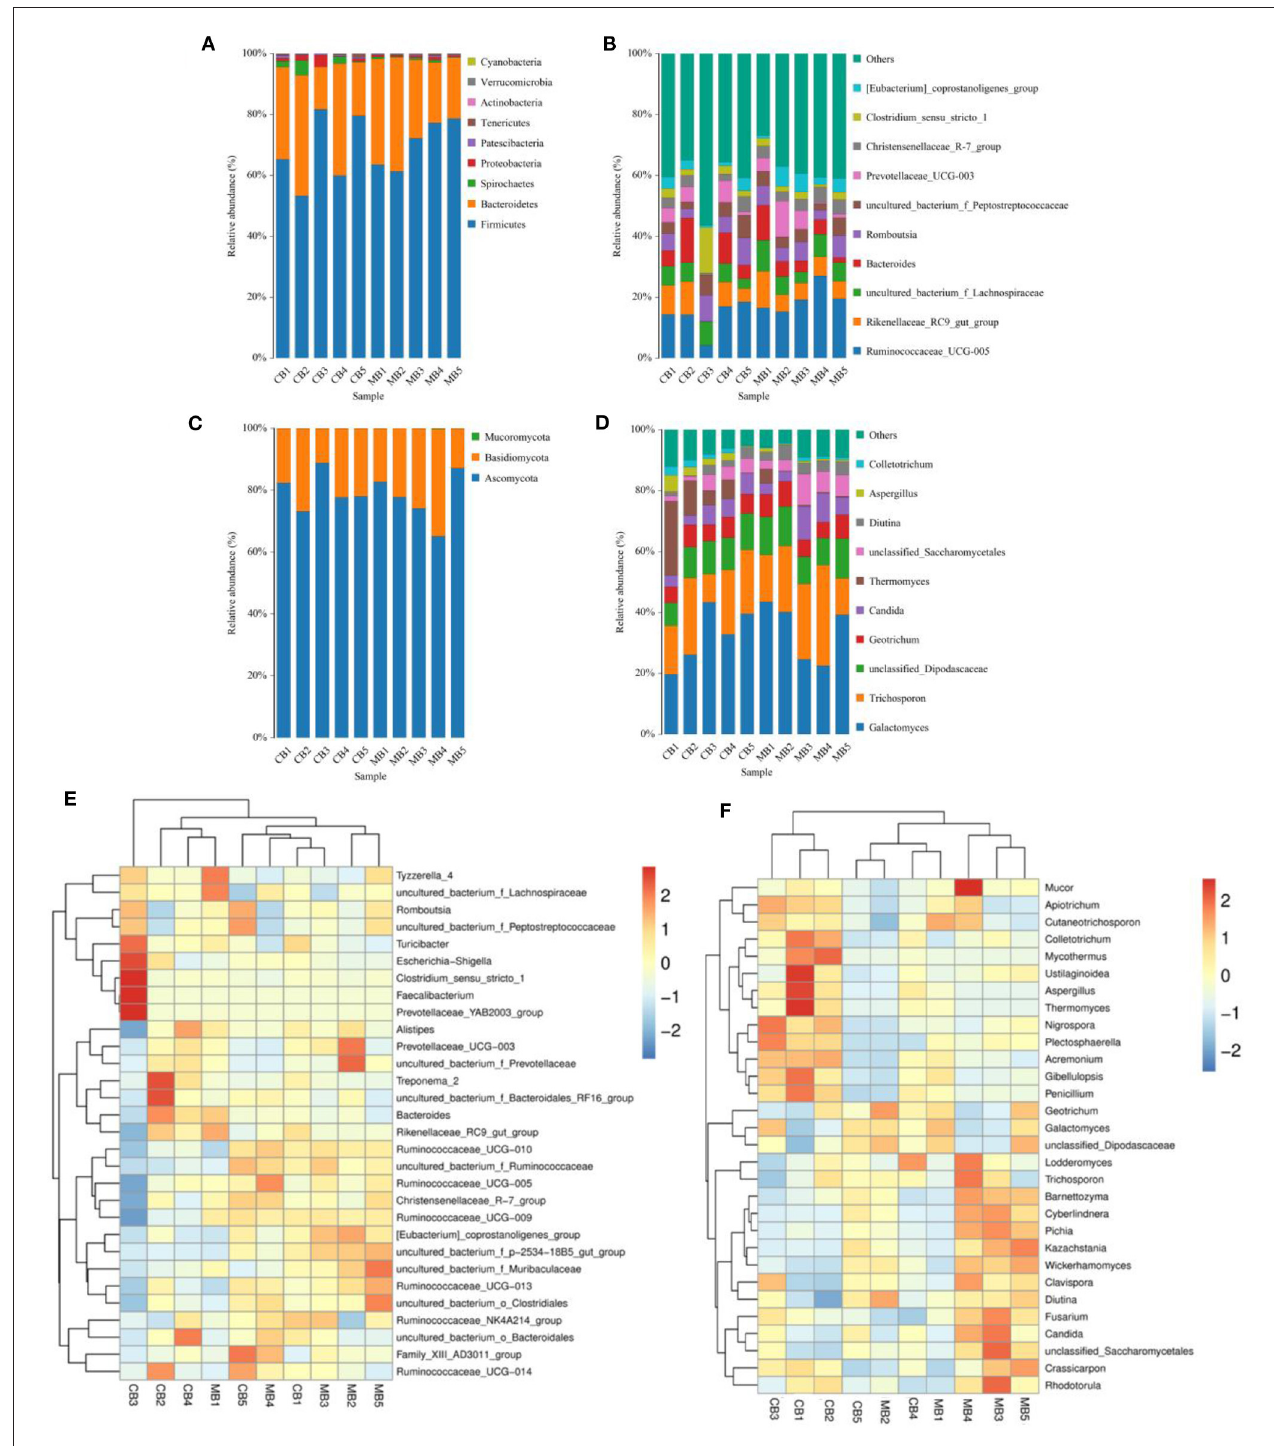
FIGURE 3 | The proportions of preponderant bacterial (A,B) and fungal (C,D) taxa at the level of phylum and genus associated with mastitis in buffalos. The color-block in the heatmap indicates the normalized relative richness of each bacterial (E) and fungal (F) genera in healthy and mastitis-affected buffalos.